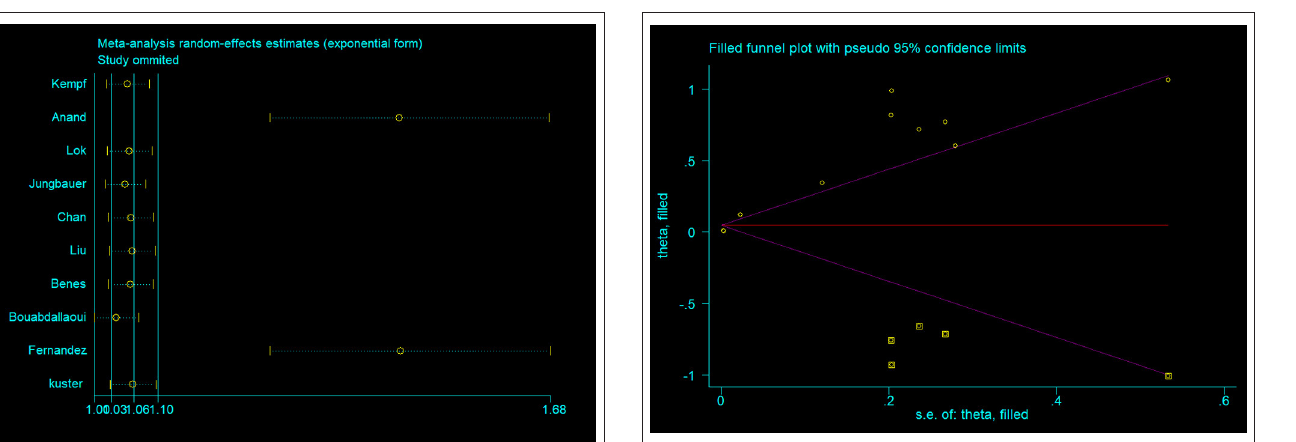
FIGURE 3 | Sensitivity analysis.